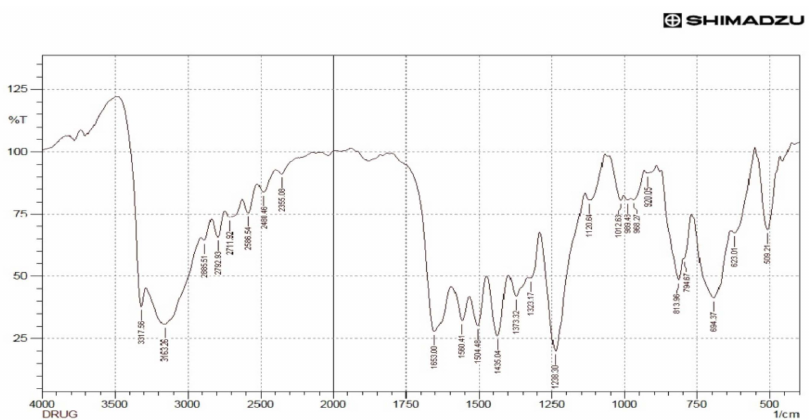
Figure 5. FTIR analysis of